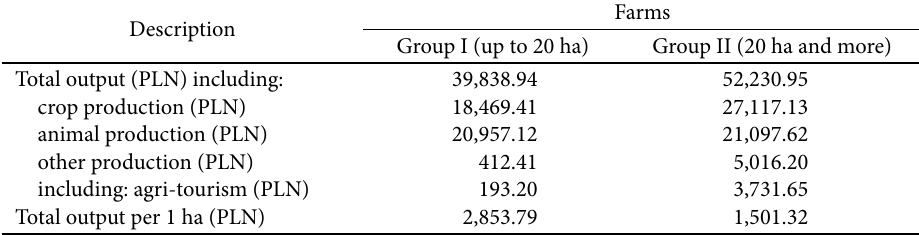
Table 4. Selected information about production of organic farm in the years 2008–2012 (per farm) Description